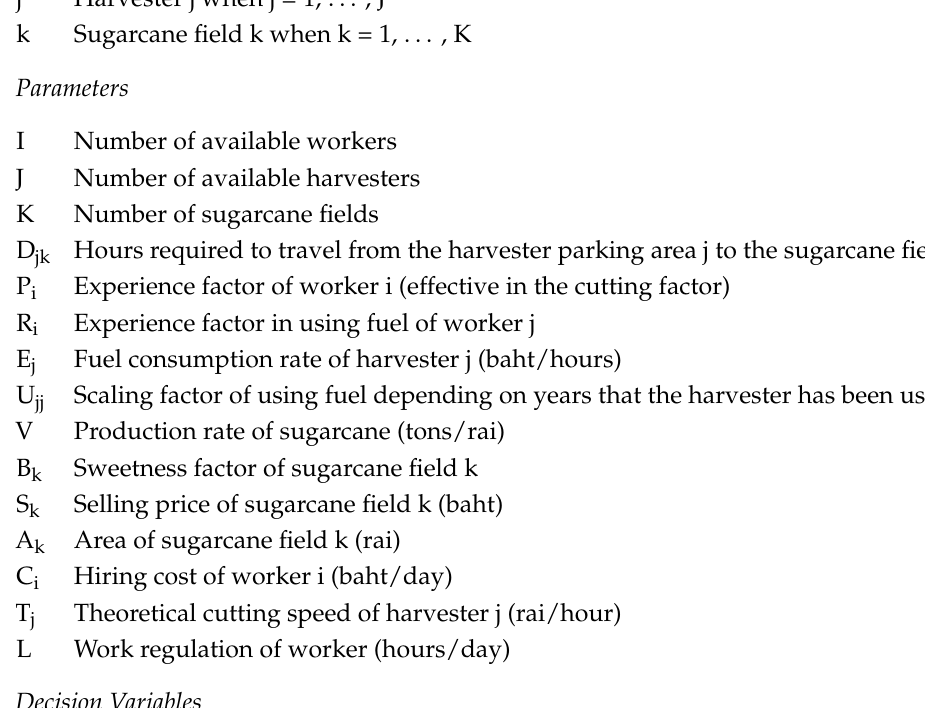
Figure 2. The solved S-GAP.